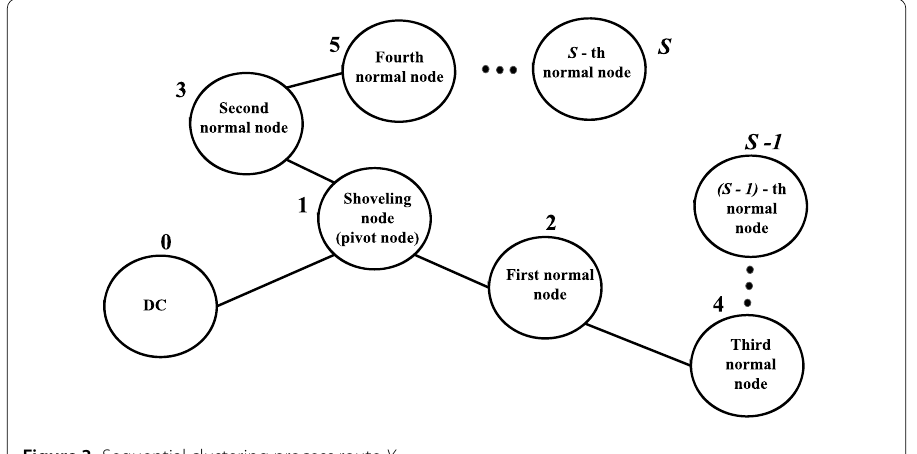
Figure 3 Sequential clustering process route